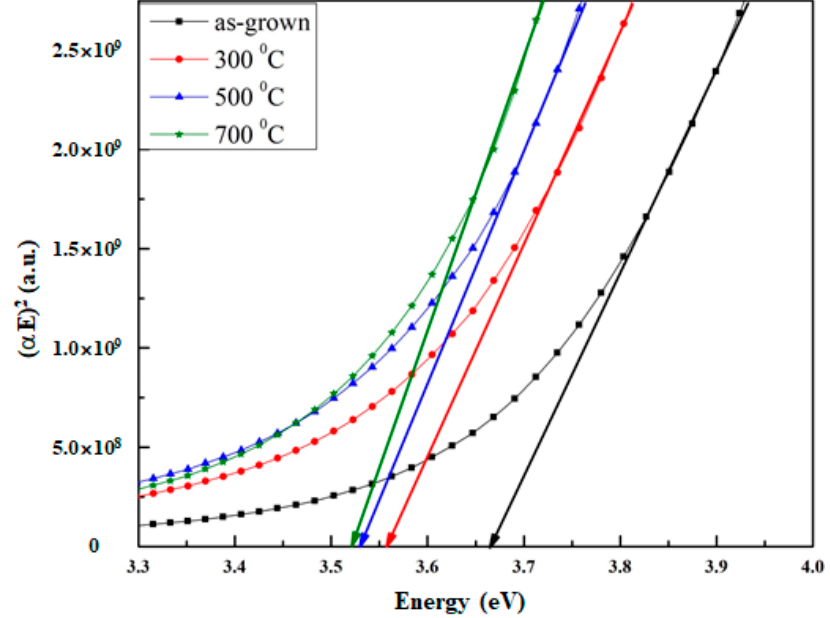
Figure 3. Tauc plots of the as-grown and the annealed TiN thin films.